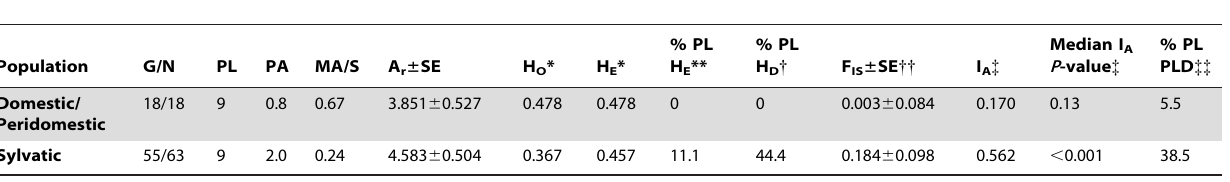
Table 1. Population genetic parameters for domestic/peridomestic and sylvatic populations of T cruzi in Loja Province, Ecuador.